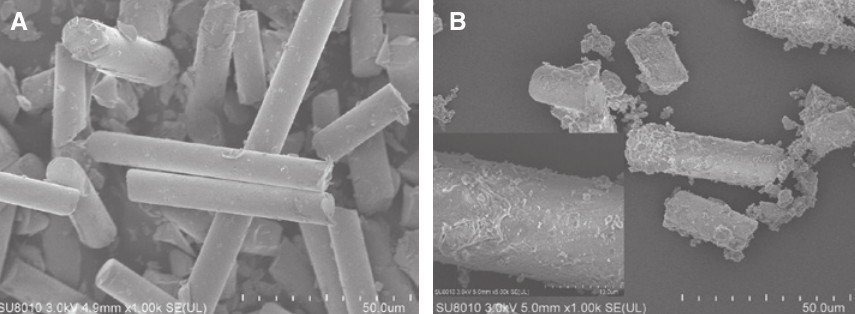
Figure 4: FESEM morphologies of the surfaces of the pristine (A) and silane-functionalizated GFs